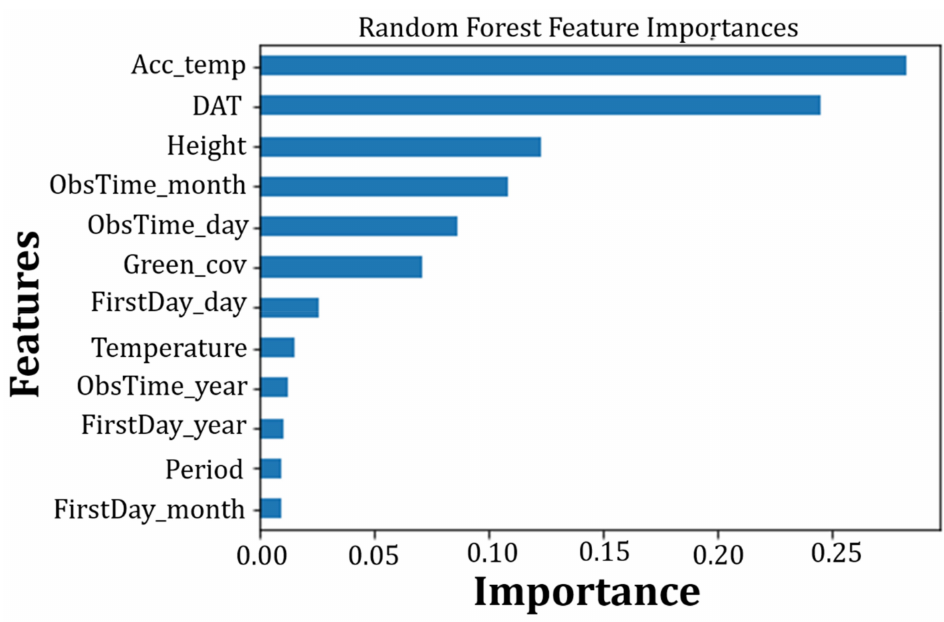
Figure 17. Confusion Matrix for Random Forest.